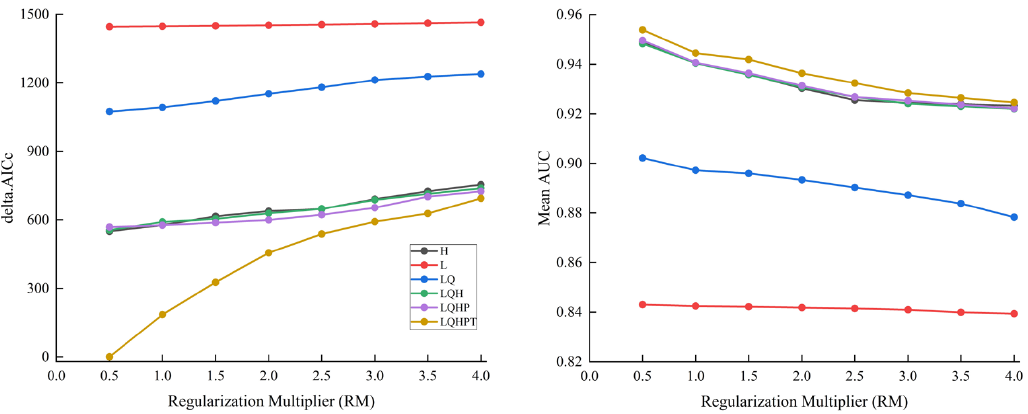
Figure 1. Results of the optimization model under different settings (L: linear; Q: quadratic; P: product; T: threshold; H: hinge).